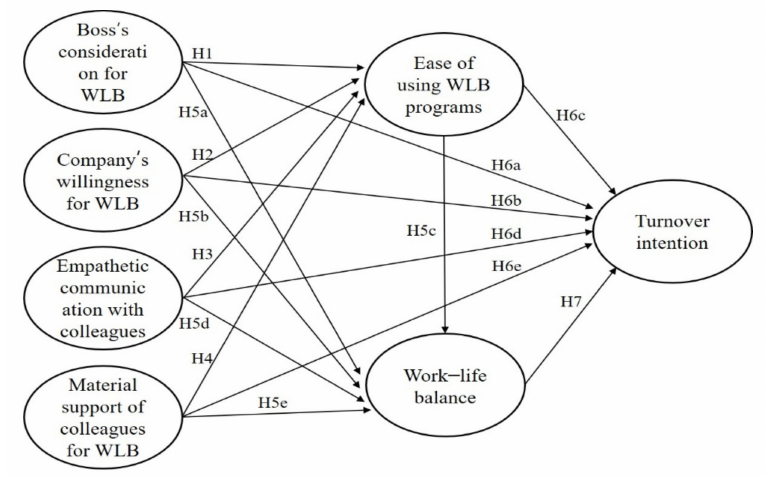
Figure 1. Research model. Note: WLB = work–life